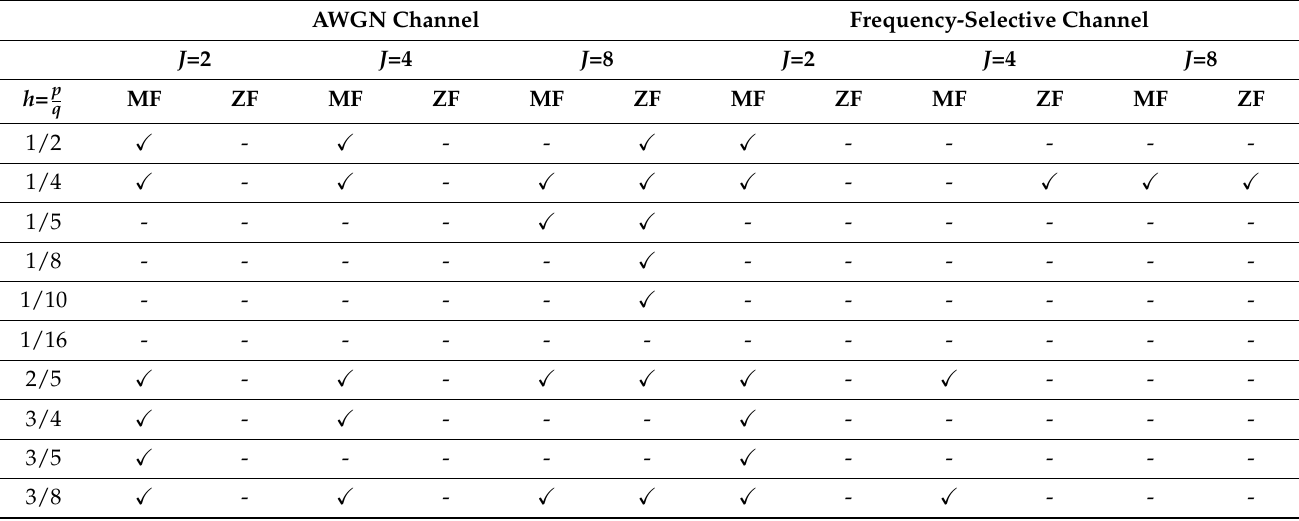
Figure 13. BER performance of binary CPM-GFDM vs. BPSK-GFDM for zero forcing receiver over frequency-selective channels . Table 4. Modulation Indices Giving Better Performance Than Conventional GFDM (Red color indi- cates best performing ℎ ). AWGN Channel